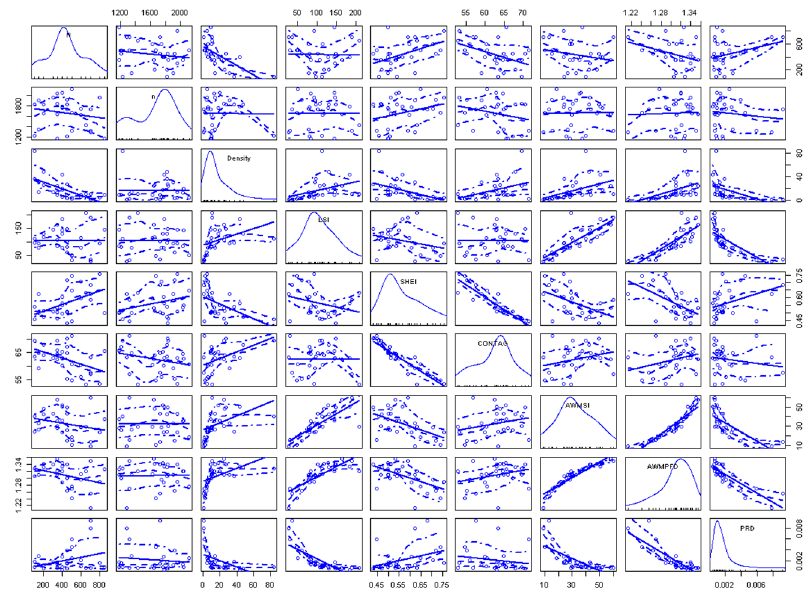
Figure 8. Scatterplot matrix between sample size N S and the predictive variables.